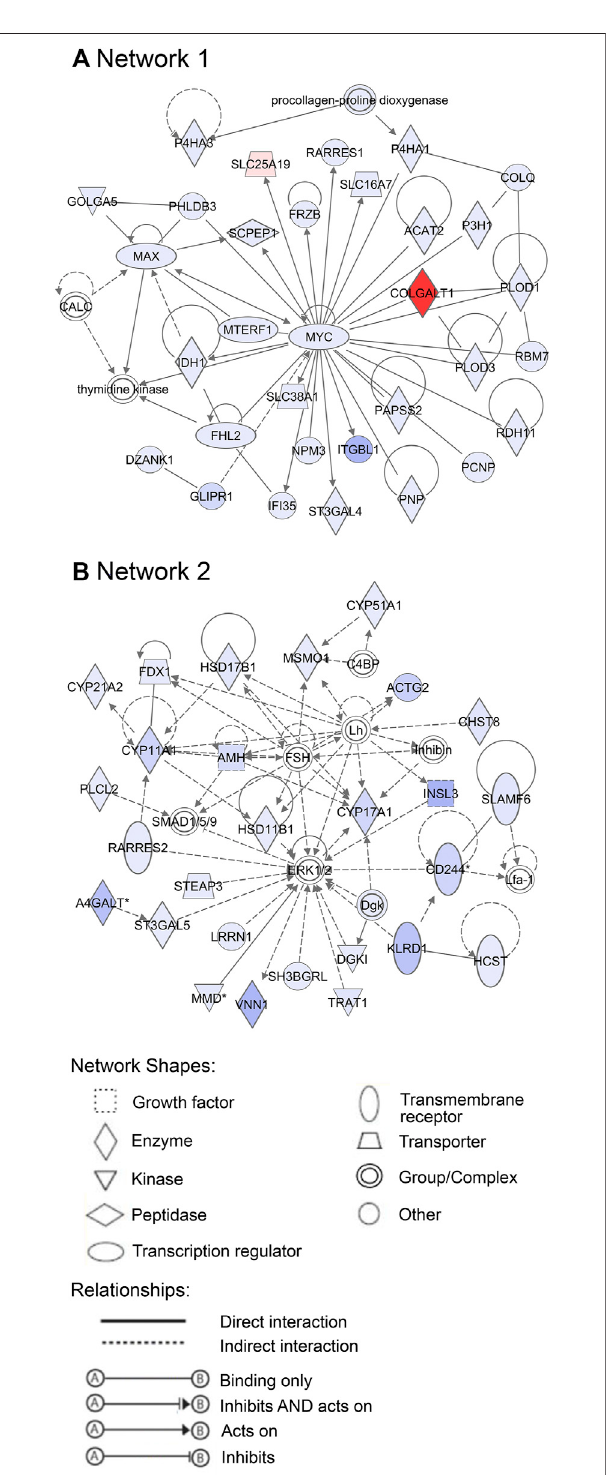
FIGURE 9 | Important networks of genes associated with cluster 4. (A) Network 1 is associated with the effects of the transcription factor MYC. (B) Network2isconnectedwithsteroidogenesis.Redrepresentsdownregulation and blue upregulation in the second half of gestation. The strength of regulation is shown by the intensity of each